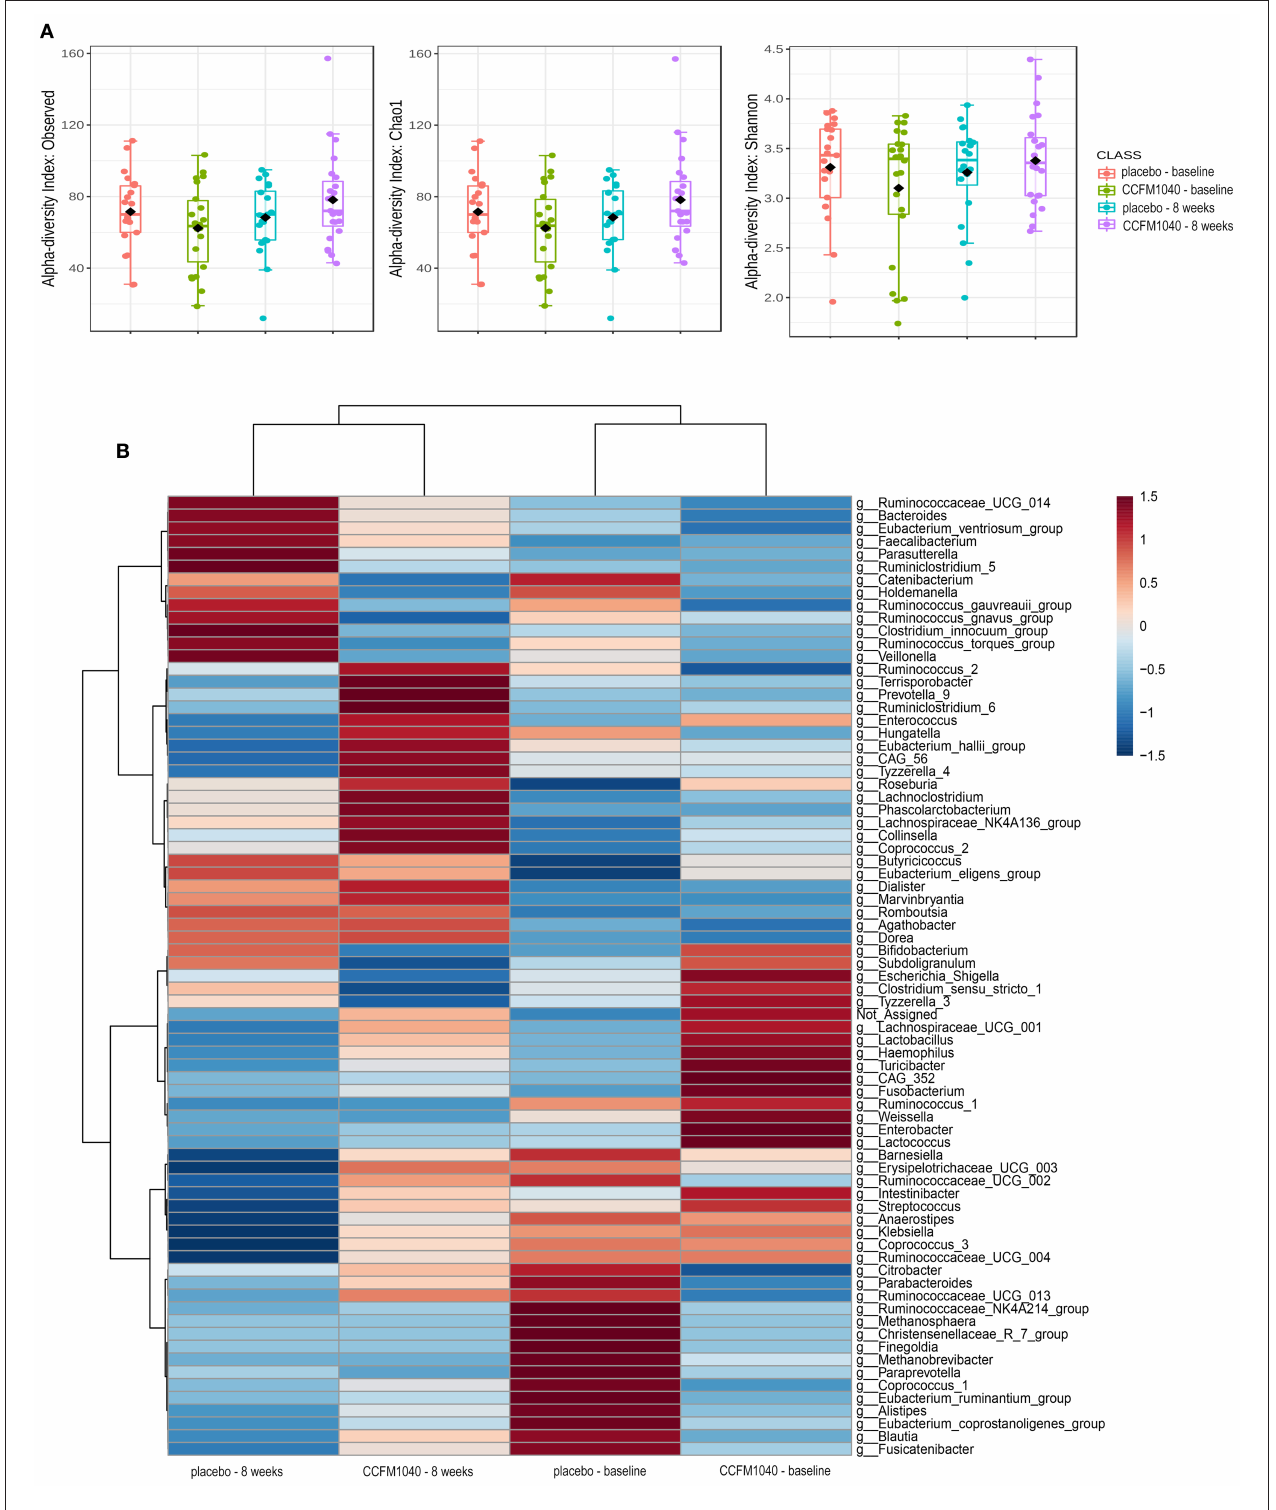
FIGURE 4 | Effect of CCFM1040 and placebo on the composition of the gut microbiota in patients with AR at the genus level. P < 0.05. (A) Boxplot for α -diversity measured based on observed, Chao1, and Shannon indices. (B) Heatmap analysis of species abundance clustering. The heatmap shows the rank based on abundance. Each column represents one group, while each row in the heatmap represents one genus. The red to blue color bar indicates the relative abundance. AR, allergic rhinitis.